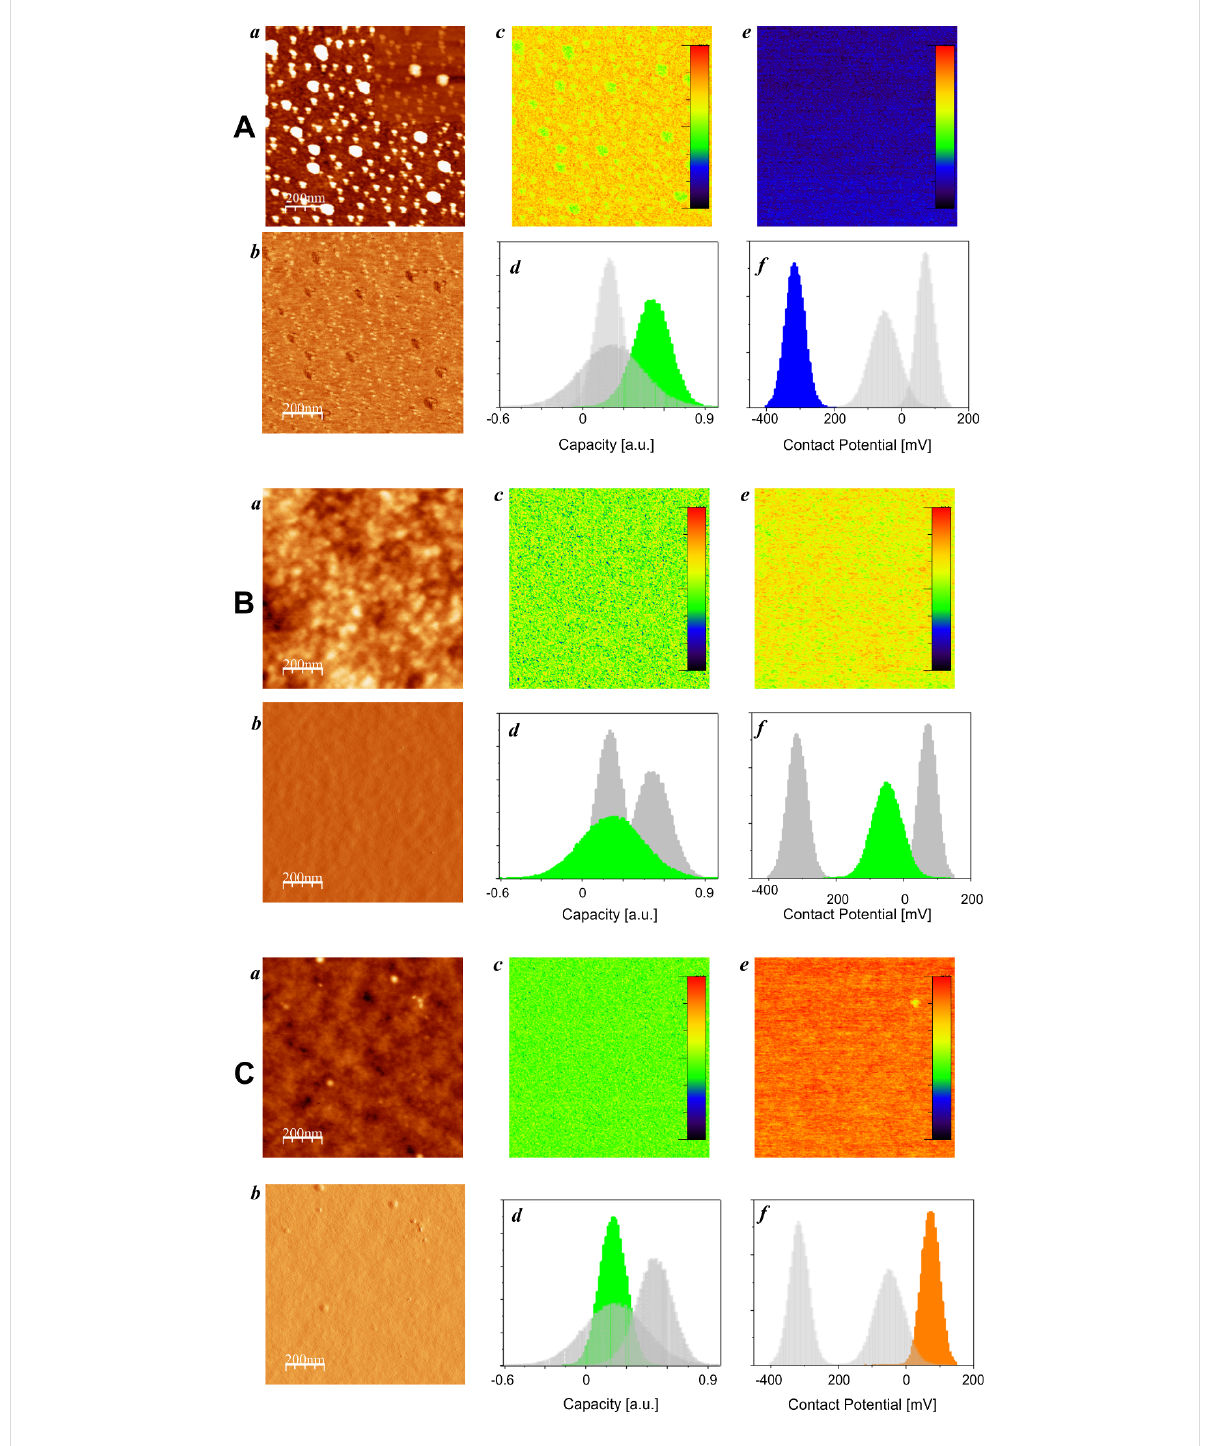
Figure 2: Topography ( a ), error signal ( b ), capacity data ( c ) and contact potential ( e ) acquired on the flat part of three platinum-coated AFM cantile- vers: “uncleaned-old“ (panel A), “uncleaned-new” (panel 2B) and “cleaned” (panel C). Image size is 1 × 1 µm 2 . Height scale for all topography images is 5 nm (with the exception of the right top inset in Figure 2A a , where it is 20 nm), the voltage range is − 600 to +100 mV for the contact potential images, and arbitrary units (output of lock-in amplifier) are given for the capacity images. The histograms ( d ) and ( f ) show the variation of data in the corresponding images above, namely capacity ( c ) and contact potential ( e ). We note that data is shown in “logic order”, rather than ordered by time, in order to avoid contamination from the sample to the tip. The chronological order in which these images were acquired is: first the sample “uncleaned- new”, then (RCA) “cleaned”, and finally